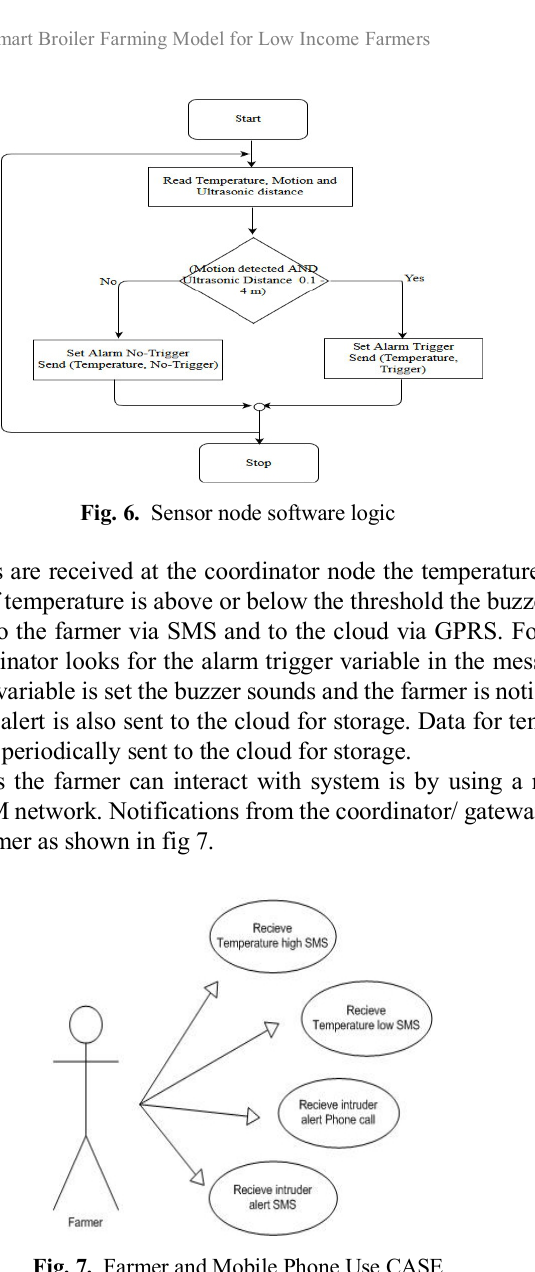
Fig. 7. Farmer and Mobile Phone Use